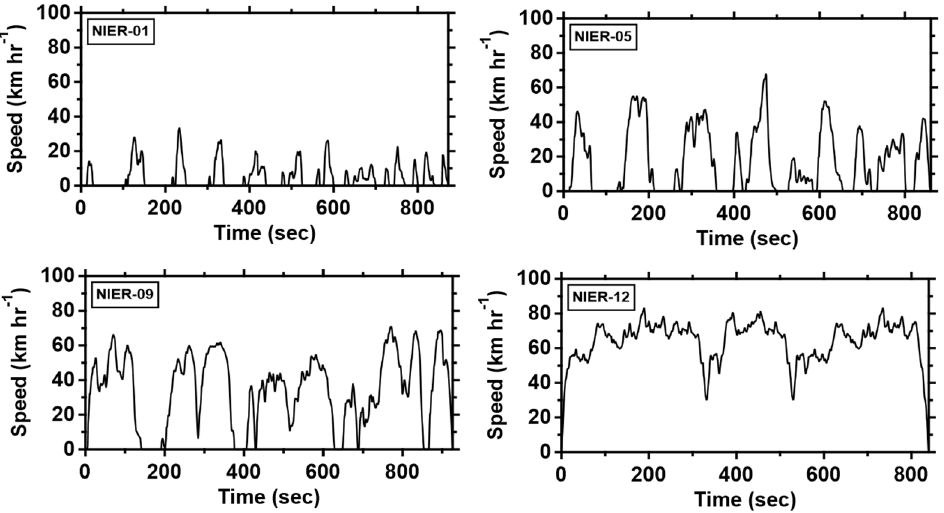
Figure 1. Speed profiles concerning test cycles considered in this study.